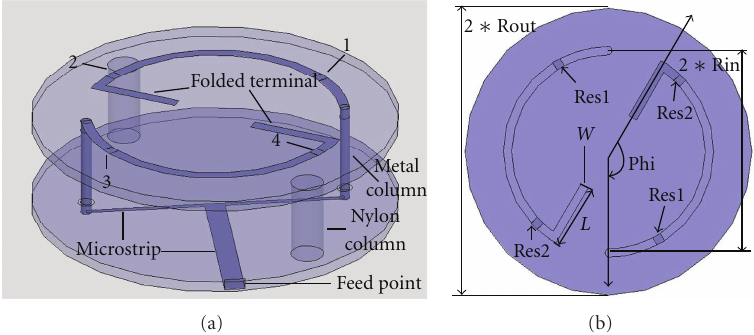
Figure 1: Model and structure of the proposed antenna: (a) 3D view and (b) Top view.